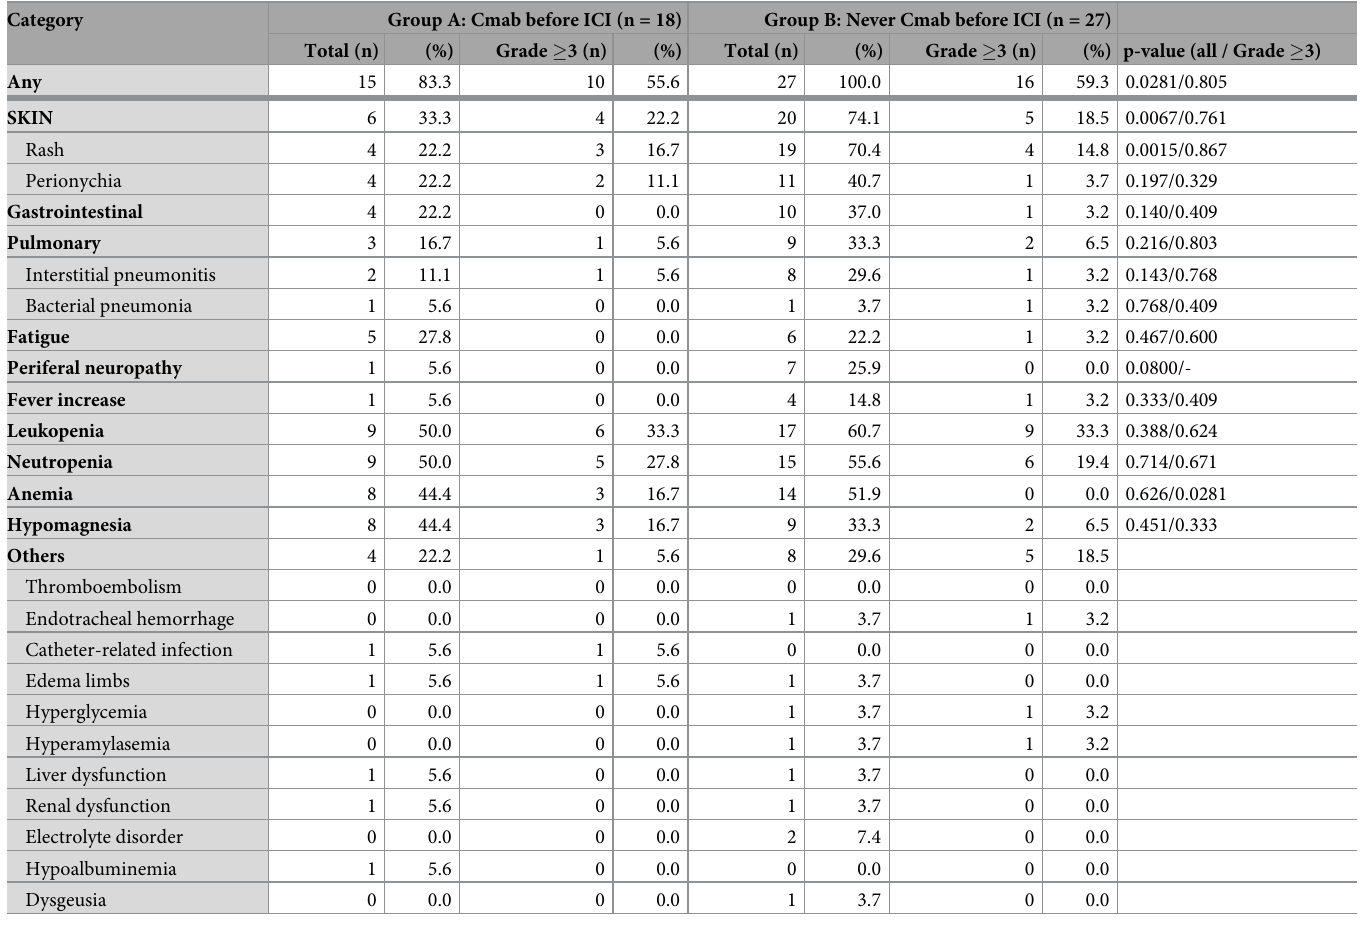
Table 4. Profiles of AEs that appeared during SCT (paclitaxel and cetuximab; Group A vs. Group B).